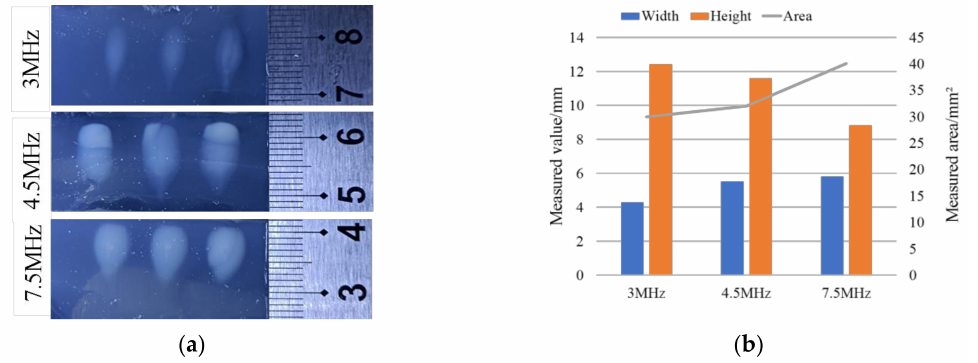
Figure 3. PAA phantom treatment experiment: ( a ) physical pictures of treatment results; ( b ) damage measurement results of the PAA phantom.